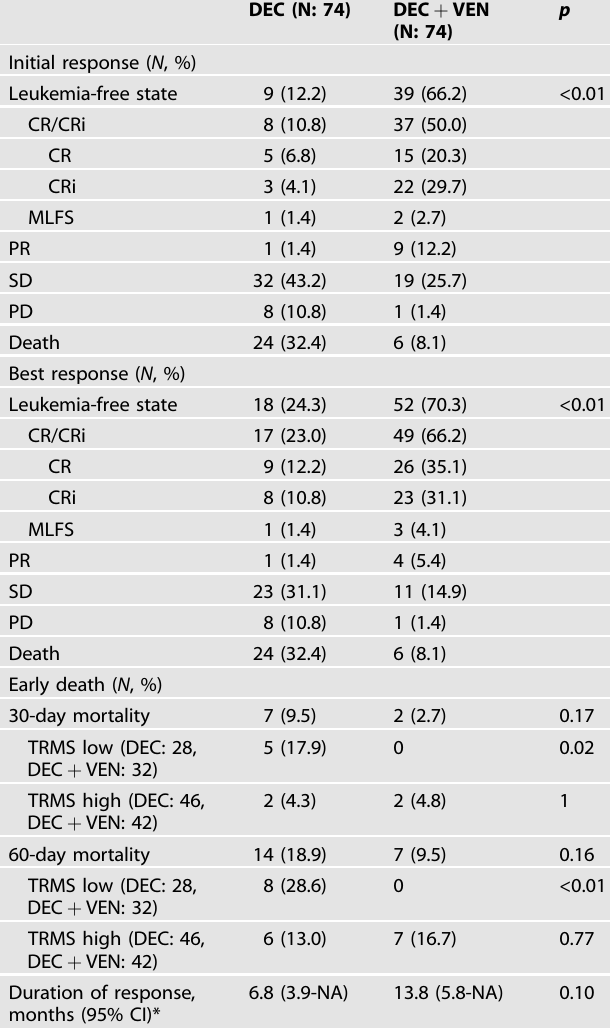
Overall, the 30-day and 60-day mortality rates did not differ between the groups (30-day mortality: 9.5% vs. 2.7%, p = 0.17; 60-day mortality: 18.9% vs. 9.5%, p = 0.16). There were two deaths within 30 days due to pneumonia with sepsis and tumor lysis syndrome, respectively, in the DEC + VEN group, and 5 additional deaths (one in CRi, and the others in no hematologic response after the fi rst cycle) by infection occurred until day 60. In the DEC group, mortality was caused by infection, hemorrhage, and pulmonary thromboembolism (Supplementary Table 2). In the low TRM risk group, the early mortality rate was lower in the